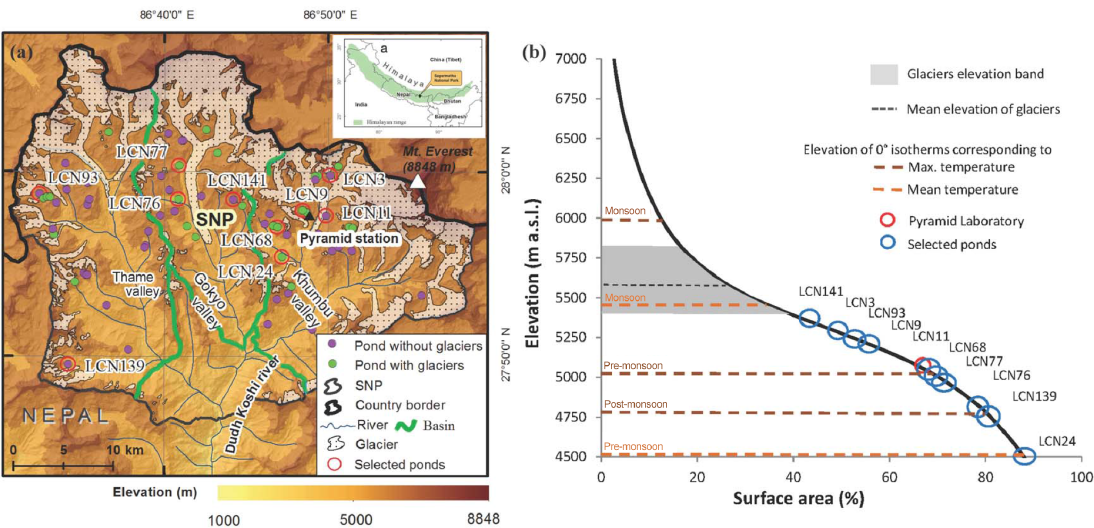
Figure 2. (a) Location of the study area in the Himalayas and a detailed map of the spatial distribution of all 64 unconnected ponds considered in this study. (b) Hypsometric curve of SNP. Along this curve, the locations of 10 selected ponds are shown. The 0 ◦ C isotherms corresponding to the mean and maximum temperature in 2013 are plotted for the pre-, post-, and monsoon period according to the lapse rates reported in Salerno et al. (2015). The mean glacier elevation distribution (mean ± 1 standard deviation) of 10 selected ponds and the location of the Pyramid meteorological station are also